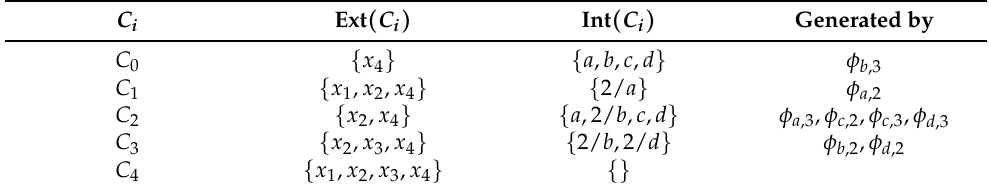
Table 1. Concepts of the one-sided formal context of Example 1 and their generating fuzzy attributes. C